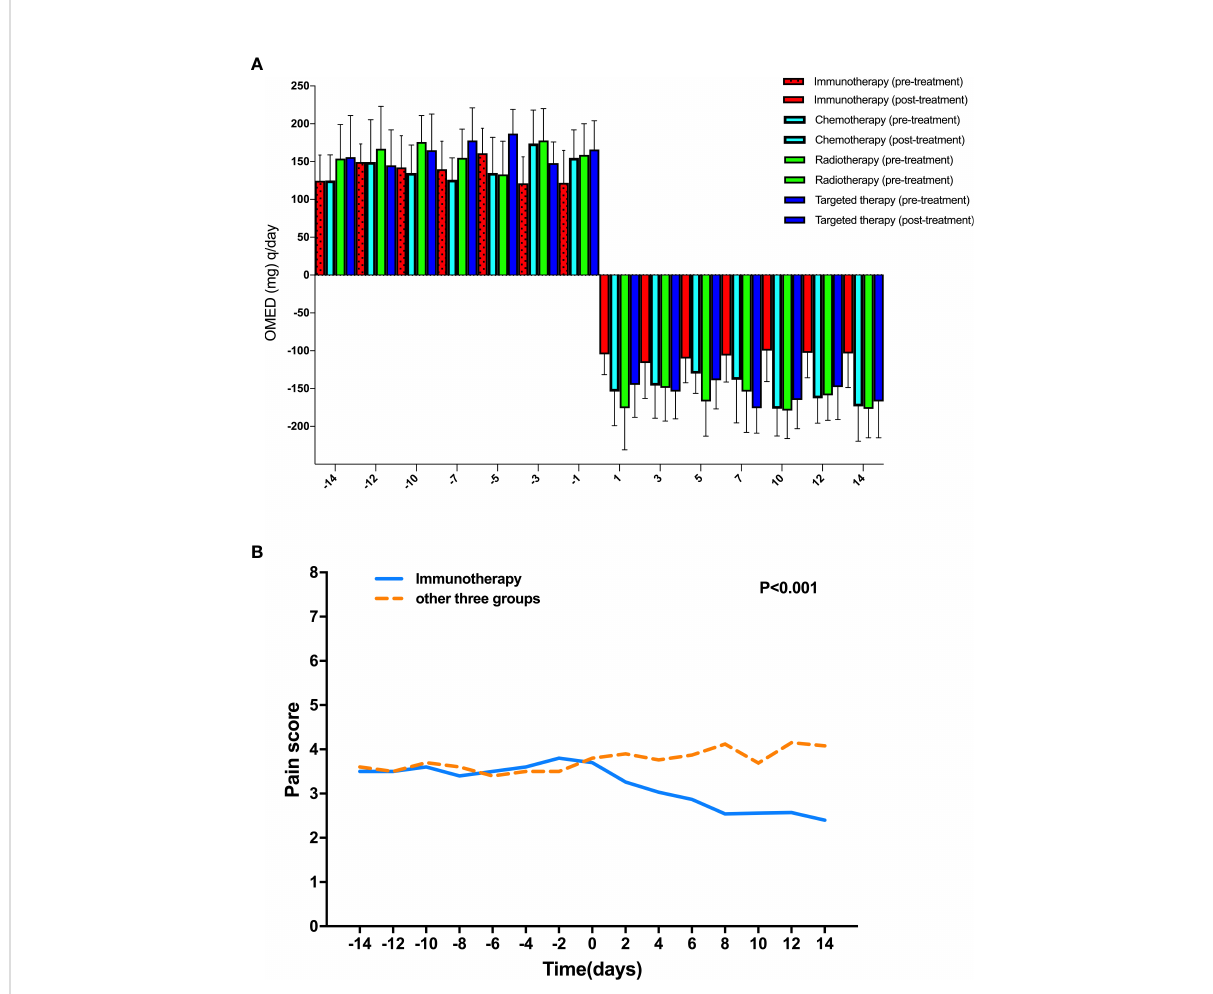
FIGURE 2 Comparison of pain management in different groups. (A) Comparison of OMED (mg) q/day 14 days before and after various treatments after PSM analysis; (B) Comparison of NRS scores 14 days before and after various treatments after PSM